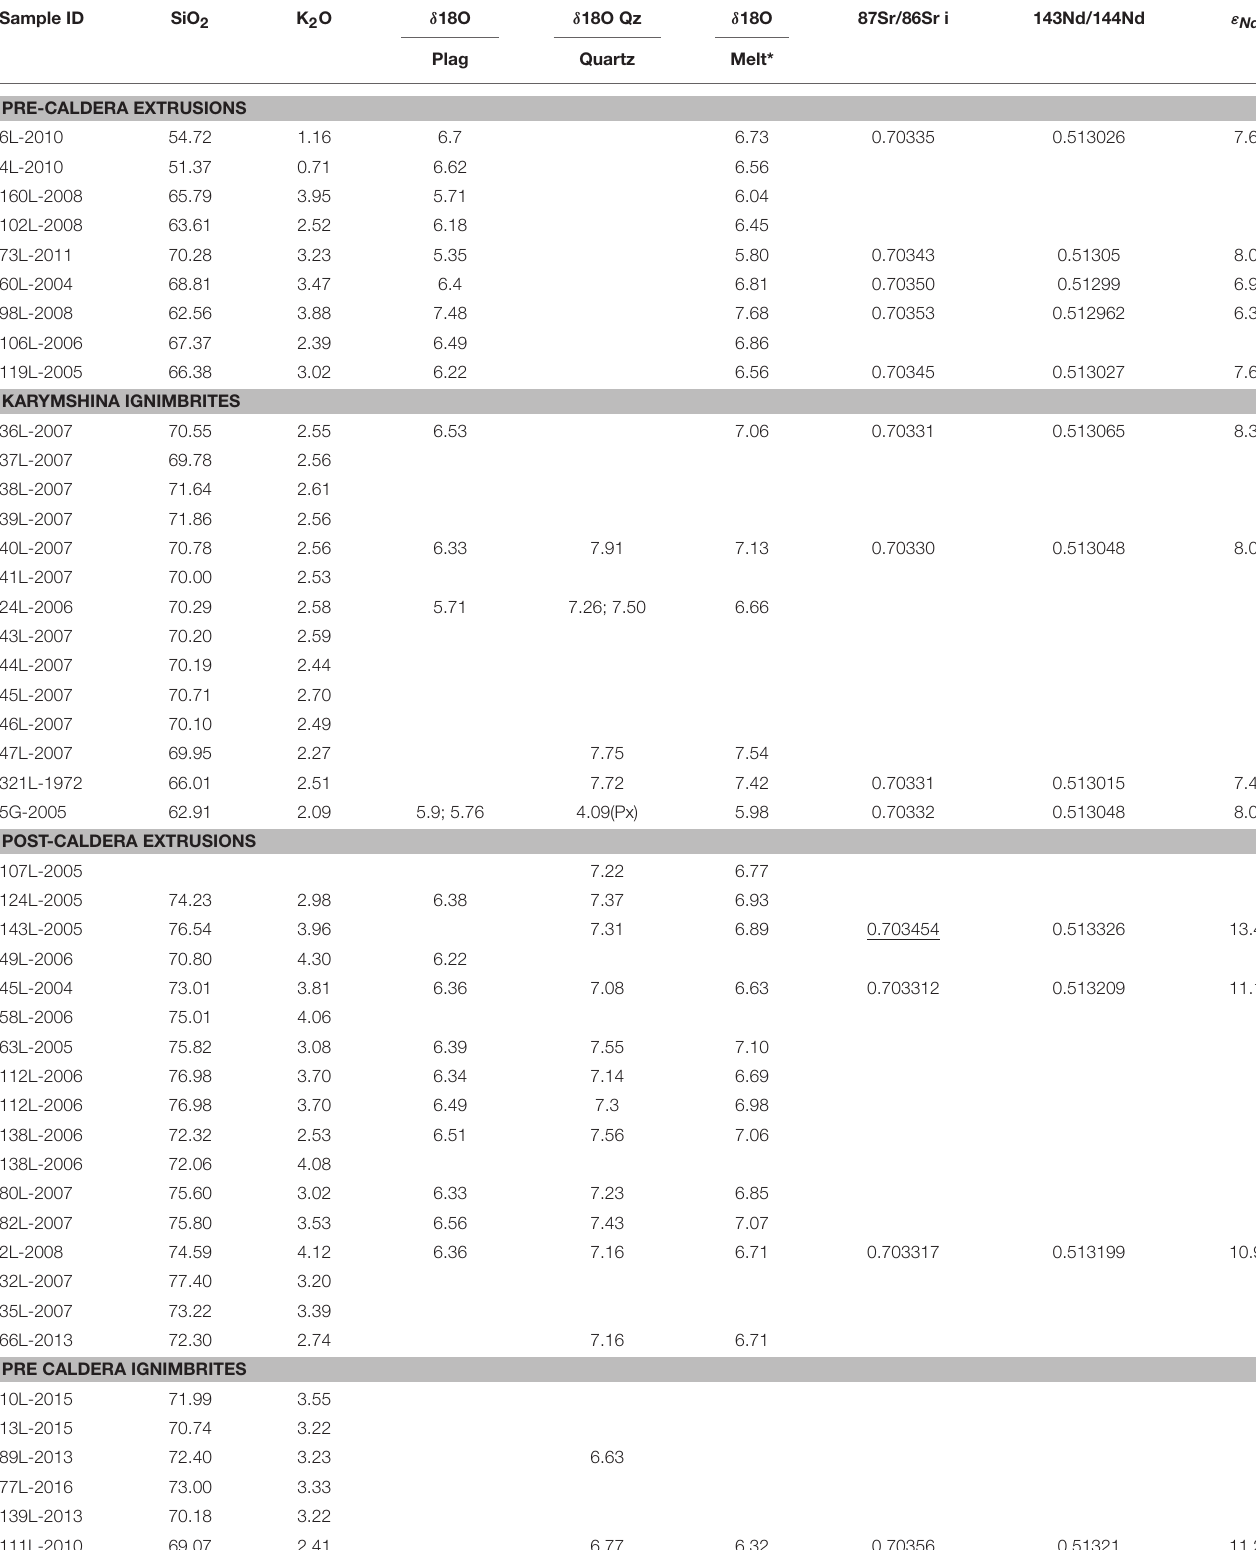
TABLE 3 | Isotope analyses of Karymshina Volcanic Complex samples. Sample